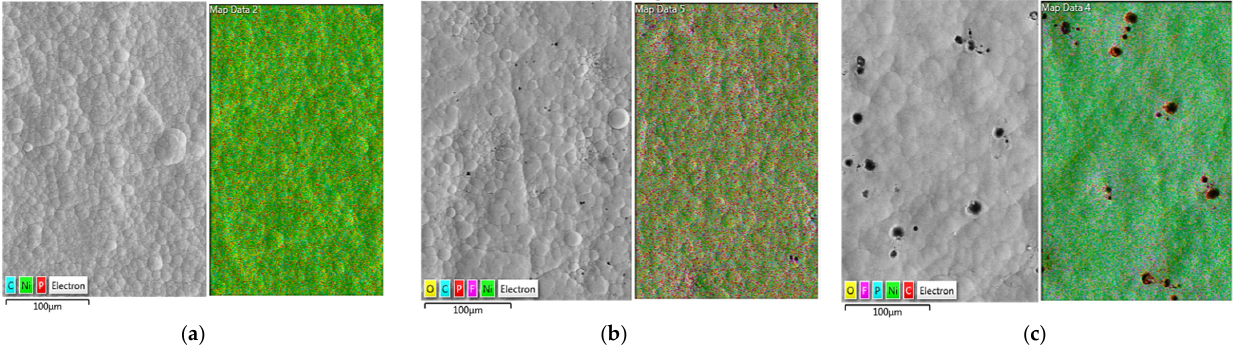
Figure 2. SEM micrographs showing surface morphology and the corresponding elemental maps of ( a ) ENP1, ( b ) ENP2 and ( c ) ENP3. Table 3. The Elemental Composition of the Surface Maps in Figure 2 of the Ni-P with Embedded PTFE Duplex Coating.